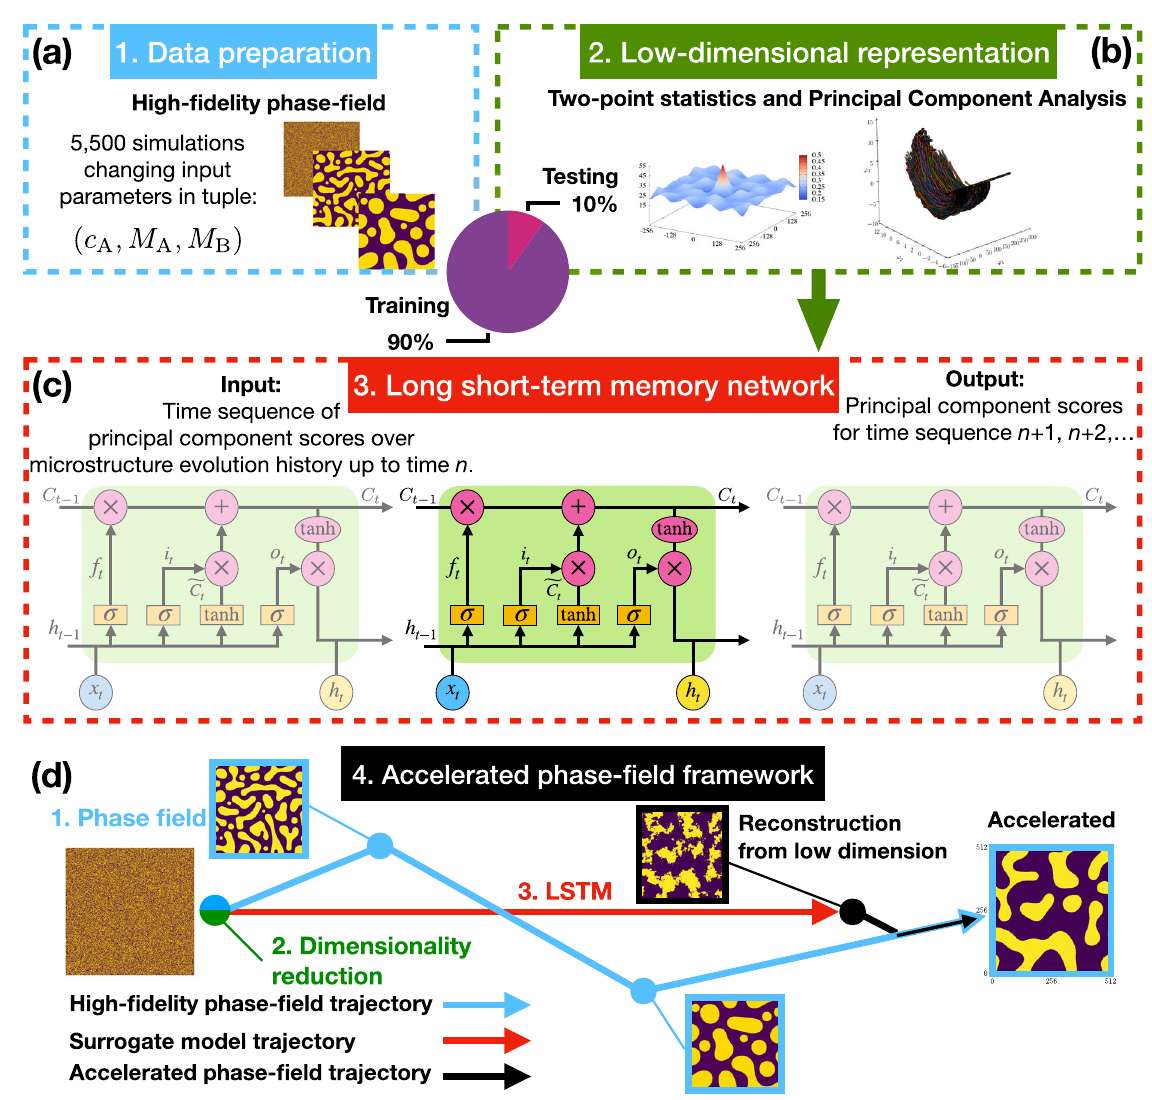
Fig. 1 Machine-learned surrogate model for accelerating phase- fi eld based microstructure evolution predictions. a Data preparation to generate training and testing phase- fi eld data sets. b Low-dimensional representation of the microstructure evolution. c Time-series analysis using a long short-term memory (LSTM) neural network to predict the time evolution of the microstructure principal component scores. d Prediction from the accelerated phase- fi eld framework based on the fi rst three